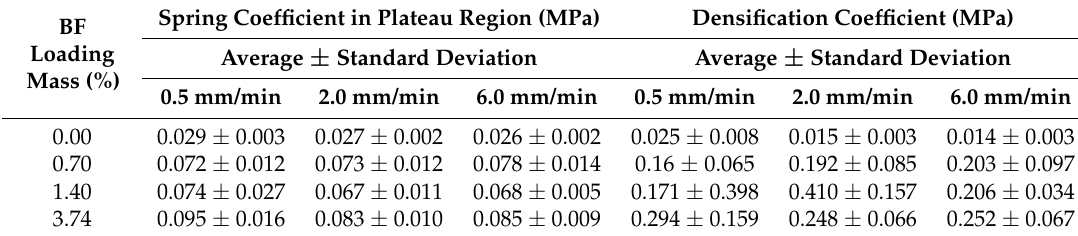
Figure 8. Fits of modified phenomenological model to compression stress–strain curves of ( a ) 0.7% BF-PDMS samples at various compression rates and ( b ) BF-PDMS samples with various BF loadings at 0.5 mm/min compression rate. Table 2. Computed best fit values of K P and γ .